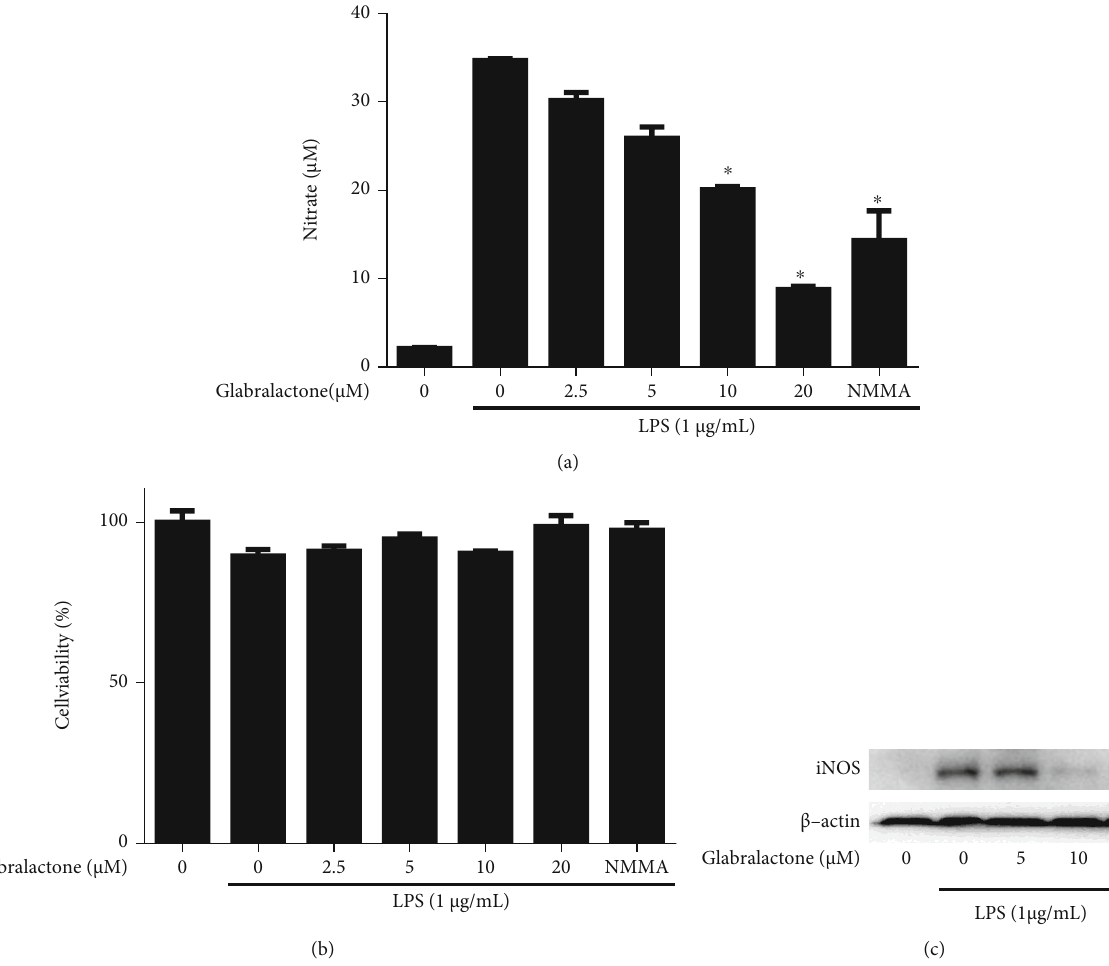
Figure 2: Inhibitory e ff ects of glabralactone on NO production and iNOS expression in LPS-stimulated RAW 264.7 cells. (a) RAW 264.7 cells were stimulated with LPS (1 μ g/mL) in the presence or absence of glabralactone. After 20h, the nitrite concentrations were analyzed in the cultured media. The values are expressed as the mean ± SD . ∗ p < 0 : 05 was considered statistically signi fi cant. (b) Cell viability was determined using MTT assay. All experiments were performed in triplicate. The data are expressed as mean ± SD . (c) The regulation of iNOS protein expression by glabralactone was determined. Cells were treated with LPS (1 μ g/mL) and glabralactone (0 – 20 μ M) for 16 h. After incubation, Western blotting was performed as described in Materials and Methods. Data are representative of three separate experiments. β -Actin was used as an internal standard. Compounds were dissolved in 100% DMSO, and the fi nal concentration of DMSO was adjusted to 0.2% (a), 0.5% (b), and 0.1%